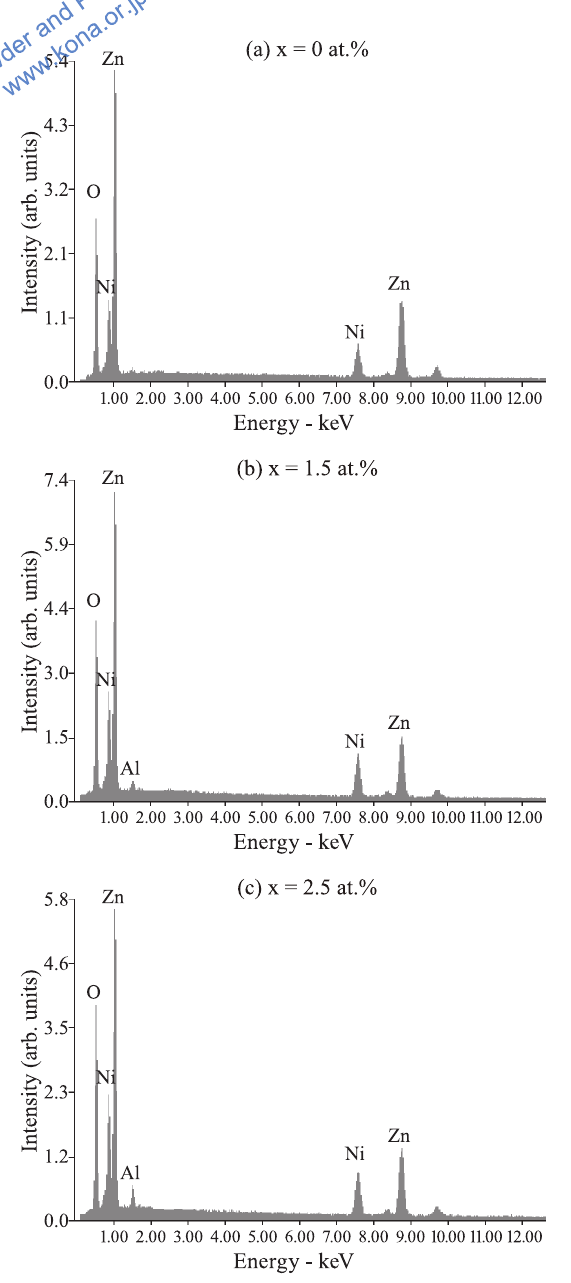
Fig. 1 Energy dispersive X-ray analyses of the Zn 0.9-x Ni 0.1 Al x O nanoparticles synthesized by the sol-gel process. (a) x = 0 at.%, (b) x = 1.5 at.% and (c) x = 2.5